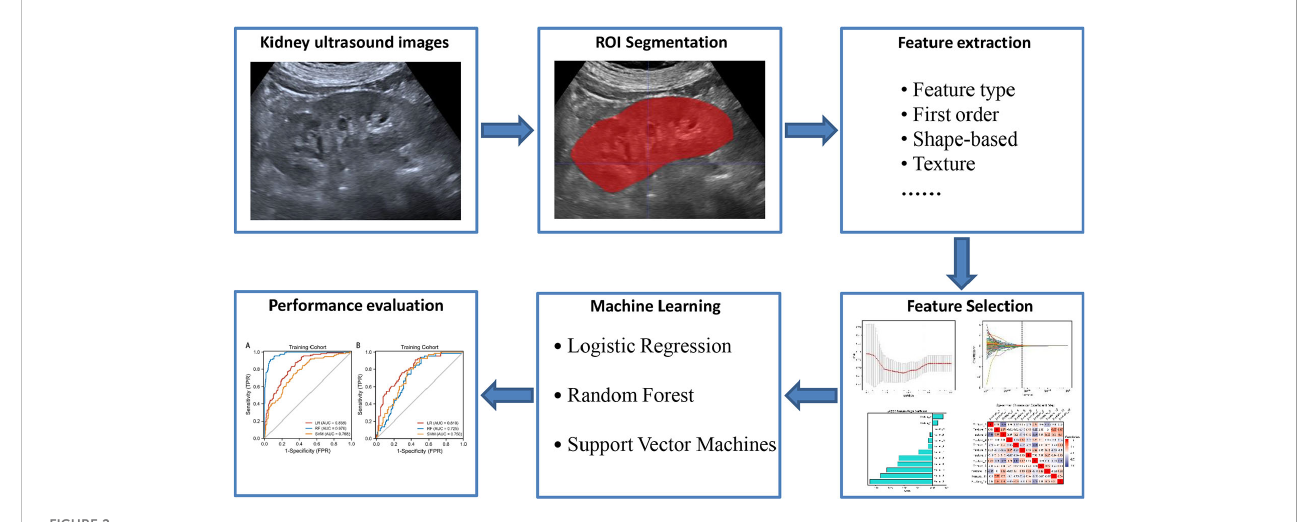
FIGURE 2 The radiomics fl ow chart of the study.